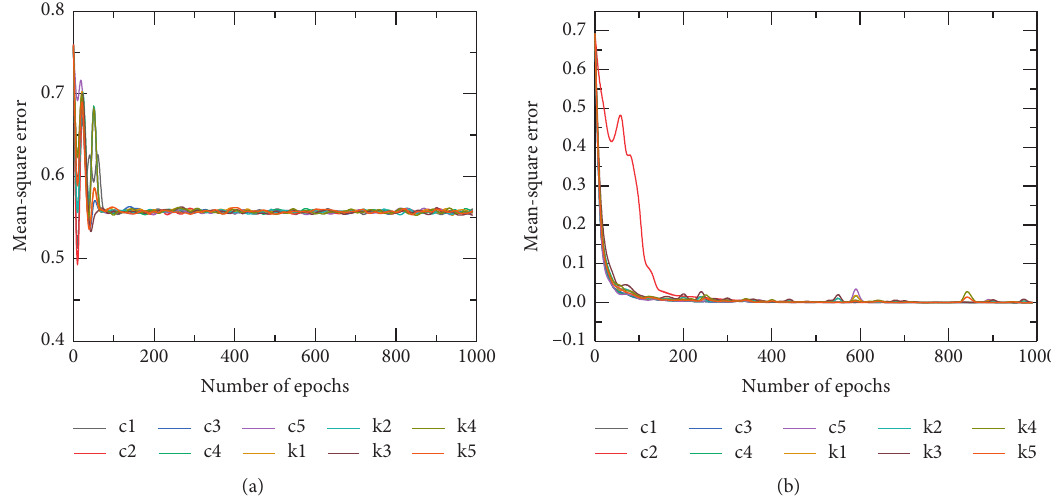
Figure 12: Comparison chart of goodness of fit and loss curve. (a) Discriminator loss curve. (b) Adversarial generator loss